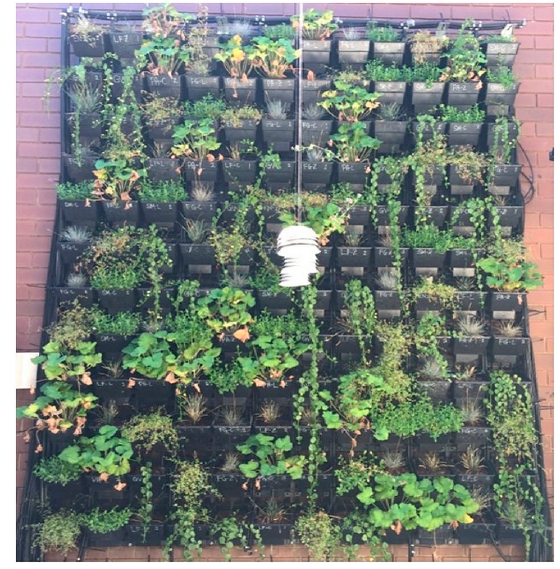
Figure 2. Experimental living wall showing the arrangement of the 144 living wall pots.